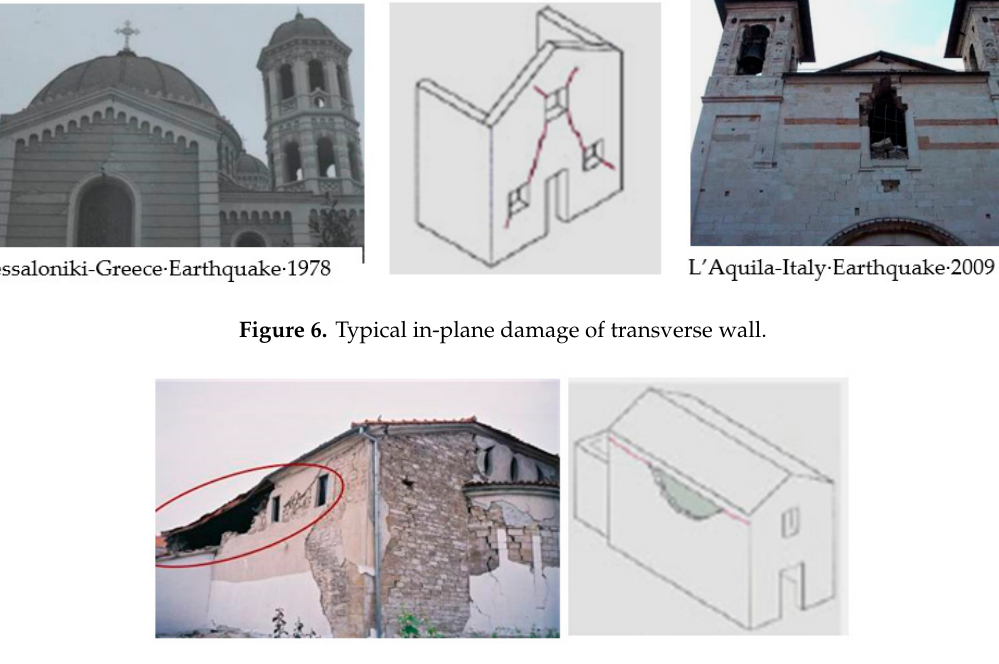
Figure 7. Typical out-of-plane damage of longitudinal wall. Kozani-Greece Earthquake 1995.